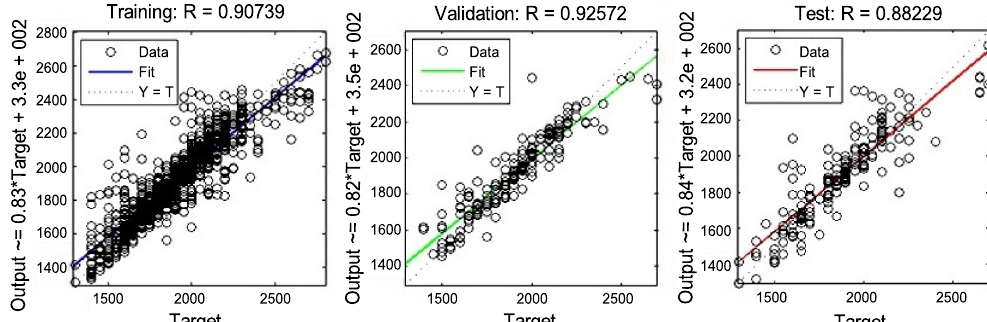
Fig. 4. Training, validation, and test data